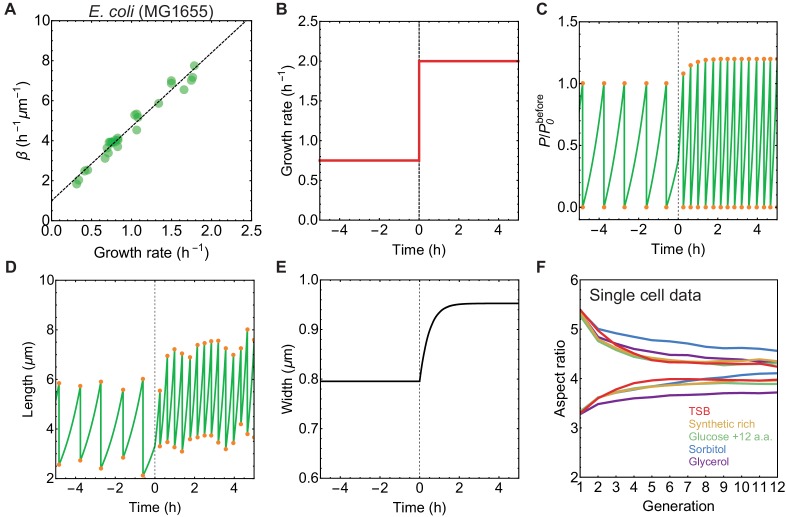
Simulations of nutrient upshift and aspect ratio equilibration at the single cell level.(A) From experimental measurement of growth rate k and cell width w we calculated surface area production rate β=4⁢k/w. Data from Si et al. (2017). Dashed black line is best fit that we used in nutrient shift simulations. (B–E) Single cell traces for simulation of cell shape dynamics during nutrient upshift. (B) Division protein vs time normalised by P0 before the nutrient shift. (C) Growth rate vs time. (D) Length vs time. Length fluctuations at division is a consequence of noise in division ratio (see Materials and methods). (E) Cell width vs time. (F) Aspect ratio of newborn cells vs generation number for single cell data from mother machine (Taheri-Araghi et al., 2015). Newborn cells with aspect ratio between 5–6 or 3–3.5 were tracked over generations. Population average for given generation number over 737–2843 cells for different growth condition is shown.